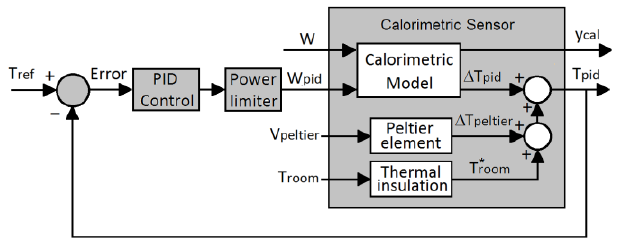
Figure 4. Calorimetry sensor operating diagram.